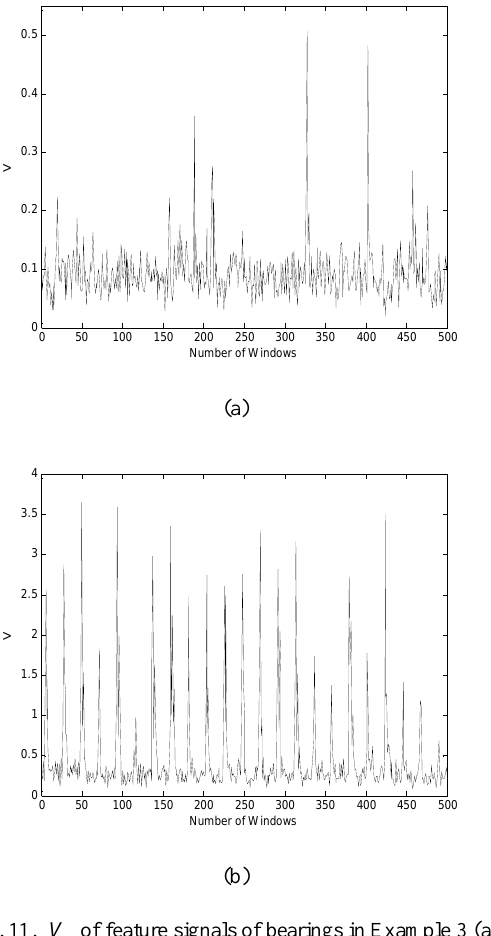
(a) of feature signal of healthy bearings, V